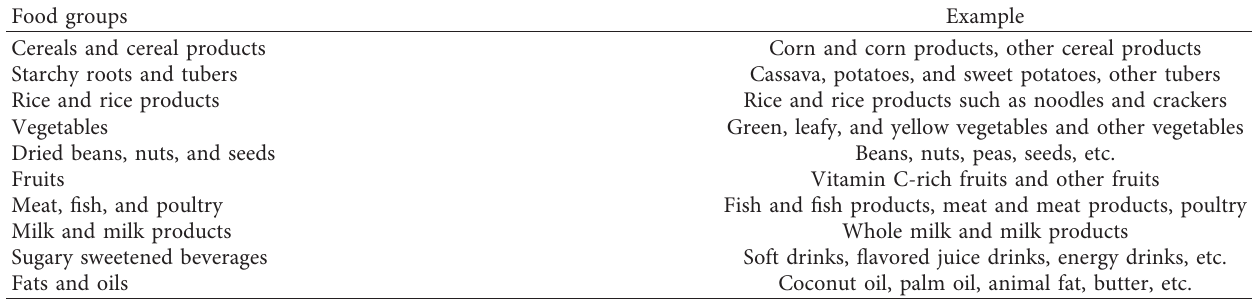
Table 1: Classification of food groups.